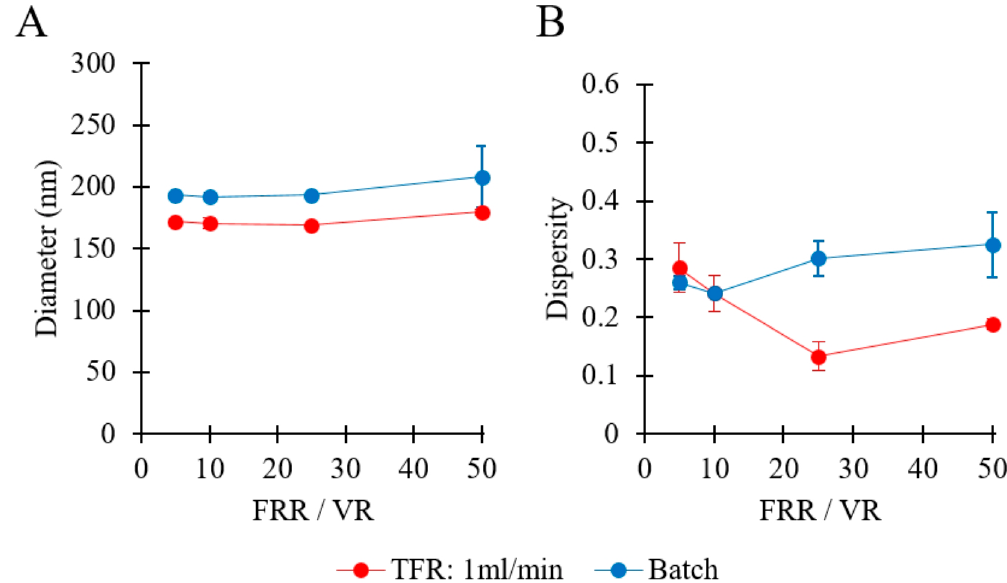
Figure 13. Comparison of production techniques in terms of liposome size ( A ) and dispersity ( B ). Methods of production included millifluidic-based (red) and batch ethanol injection (blue) methods. Data represent the means of three measurements with corresponding standard deviations. Refer to Table 1 (batch codes #1 PC to #4 PC, and #58 PC to #61 PC) for the corresponding experimental conditions, lipid compositions, and numerical data of mean values and standard deviations. FRR: flow rate ratio, VR: volume ratio, TFR: total flow rate.